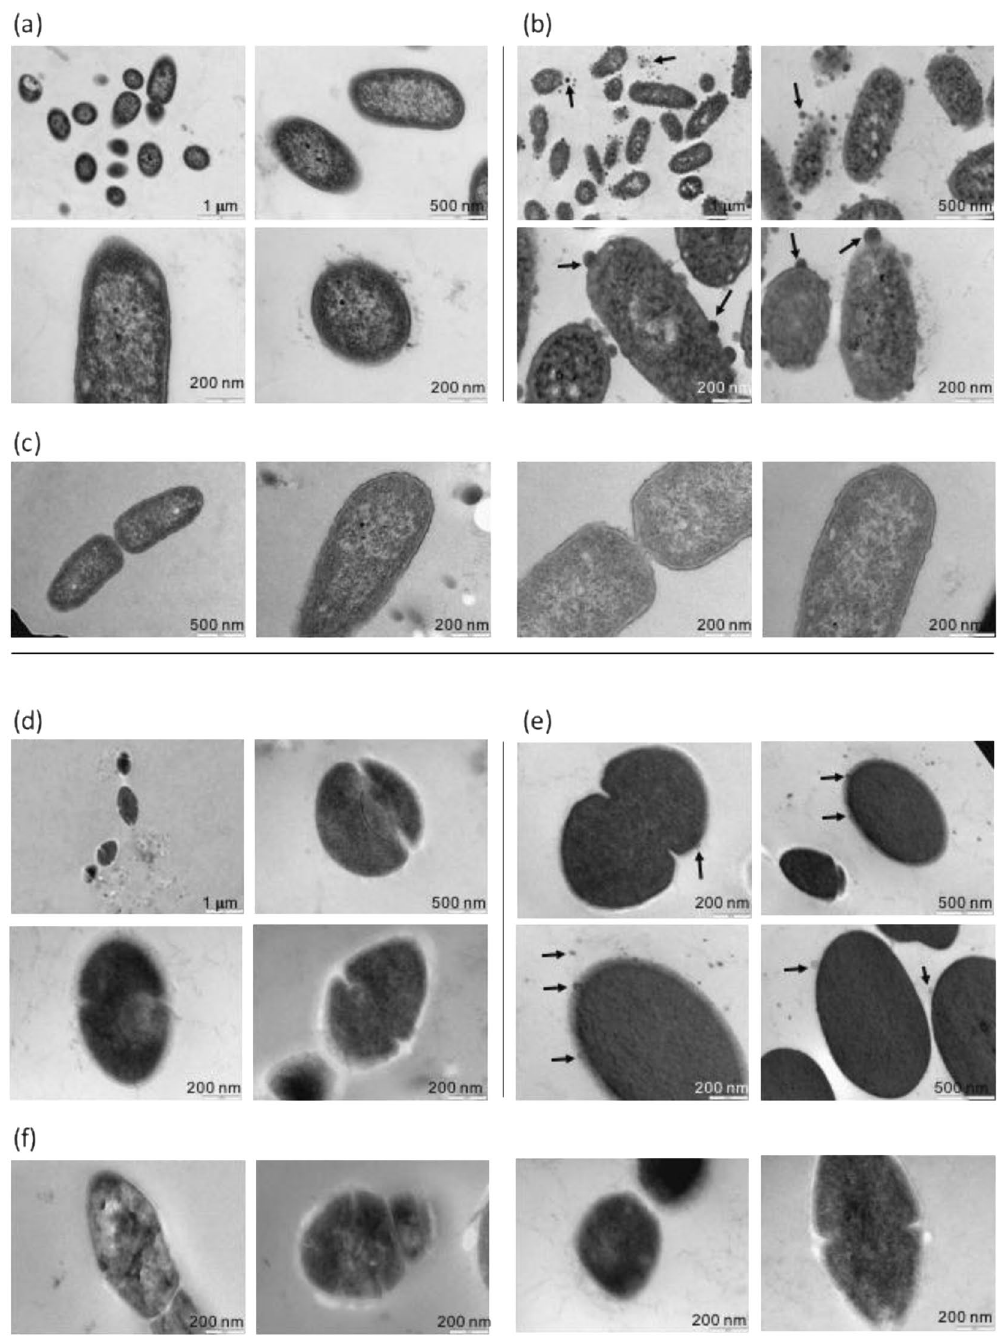
Figure 2. Transmission Electron Microscope images of P. aeruginosa ATCC 10145 and S. thermophilus DSM 20617 T before and after exposure to chlorhexidine and promysalin. ( a ) P. aeruginosa cell not exposed and ( b ) exposed to chlorhexidine (100 µ g/ml) or ( c ) to promysalin (100 µ g/ml). ( d ) S. thermophilus cell not exposed and ( e ) exposed to chlorhexidine (100 µ g/ml) or ( f ) to promysalin (100 µ g/ml). Black arrows indicate the membrane protrusions in cell exposed to